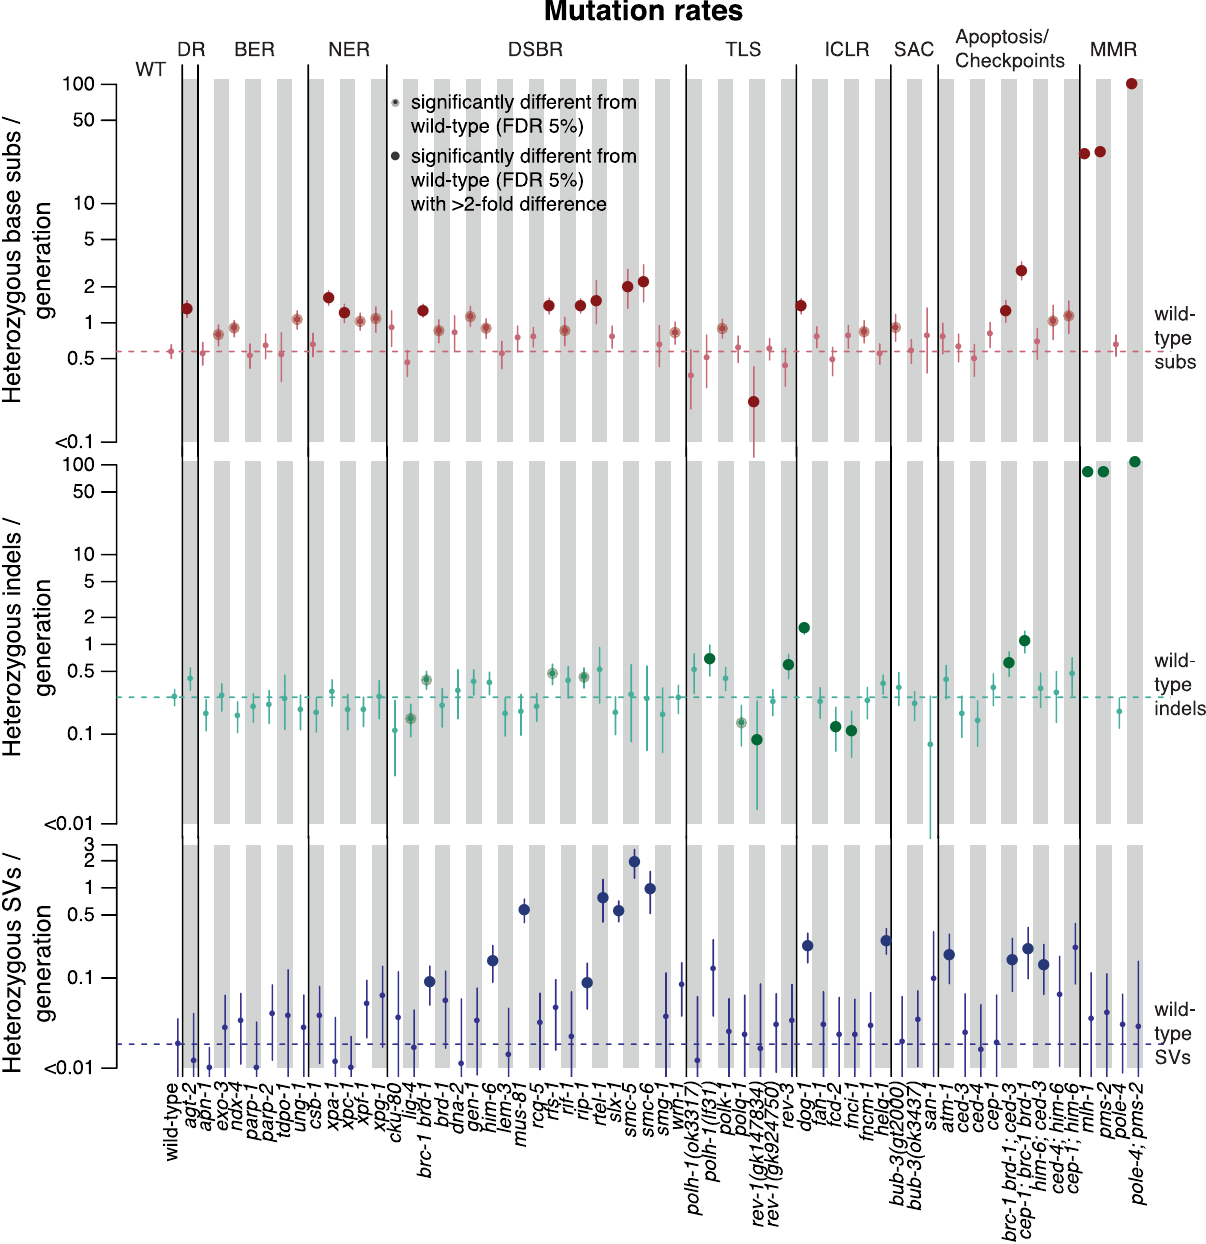
Fig 2. Mutation rates across 60 C . elegans genotypes stratified by mutation type: Base substitutions, indels, and structural variants. Mutation rates are shown as number of heterozygous mutations per generation for N2 wild-type (WT), and mutants used in this study grouped by the major DNA repair pathway they contribute to; direct damage reversal (DR), base excision repair (BER), nucleotide excision repair (NER), DNA double-strand break repair (DSBR), translesion synthesis (TLS), crosslink repair (ICLR), spindle assembly checkpoint (SAC), apoptosis, and mismatch repair (MMR). Base substitutions are shown in red (top), indels in green (center) and structural variants in blue (bottom). Dotted lines denote the mutation rates for wild- type. Error bars show the 95% confidence intervals; large dots represent variants with 2-fold increased or decreased mutation rates over N2 wild-type which are statistically significant with a false discovery rate (FDR) below 5%. All CIs which extend below the lower edge of the plot have zero as their lower border. Information related to the 528 whole genome sequencing WGS primary-source datasets (56 deposited in this study, 472 deposited in (Suppl Data 1 and Supple Note 1 of [10] can be found in S1